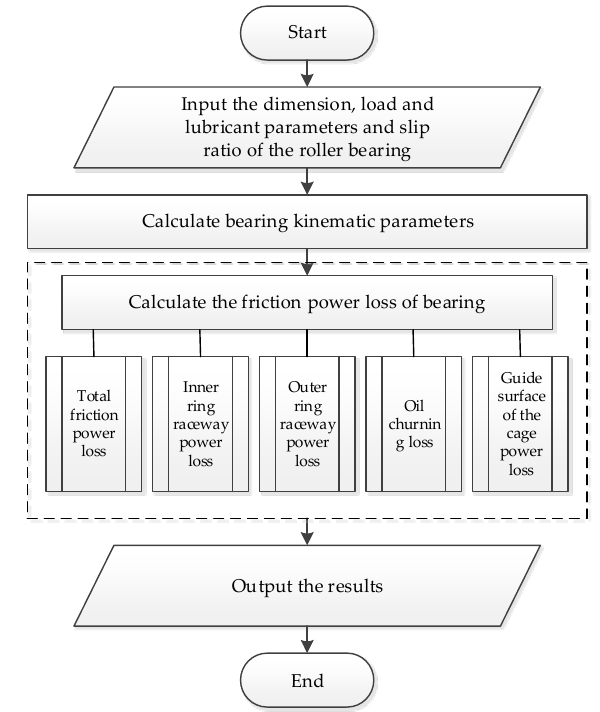
Figure 3. Flow chart of the bearing friction power loss analysis.